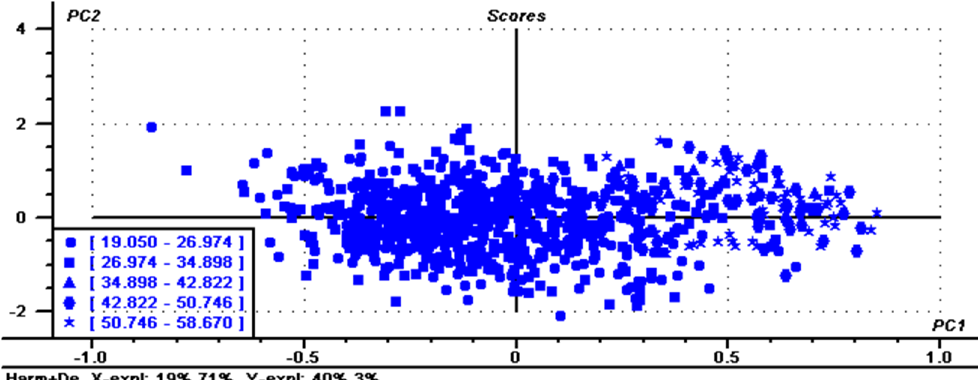
Figure 3. Principal Component Analysis score plot of single maize kernel data. Harm + De, Harmonization determination. The numerical values are the amylose content of the sample, and each shape represents a range of amylose content.